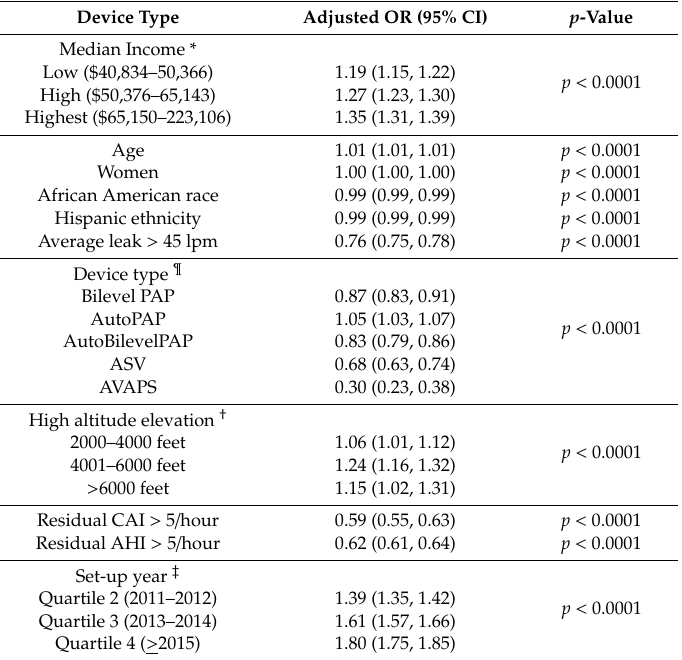
Table 4. Univariate regression of adherence to PAP therapy.